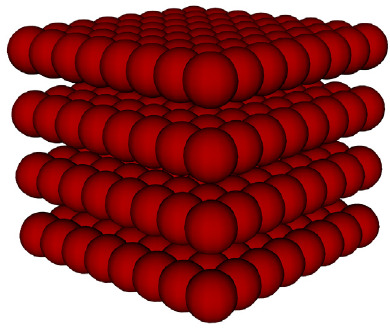
Figure 12. Illustration of a structure of 512 assembled chiral particles composed in an 8 × 8 × 8 square array.